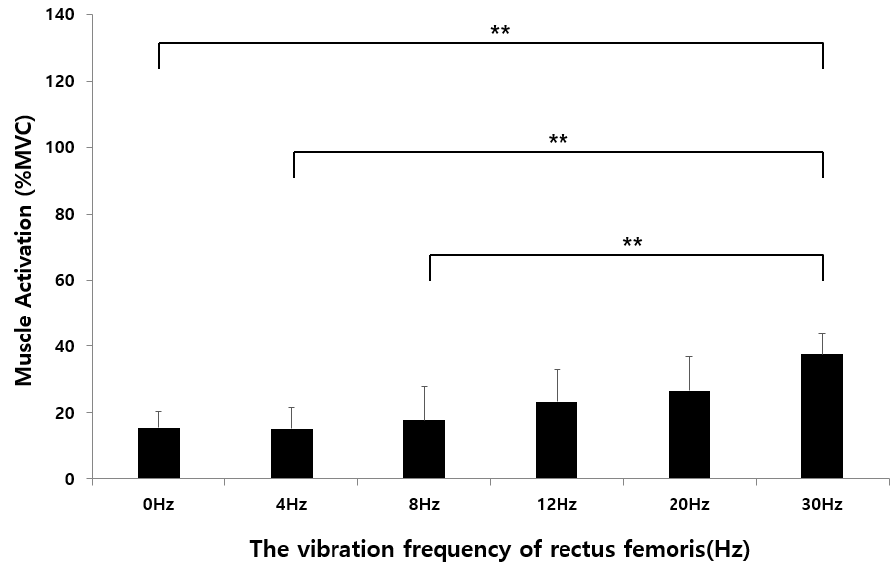
Figure 5. Results of rectus femoris muscle activation according to the vibration frequency conditions ** p < 0.01).